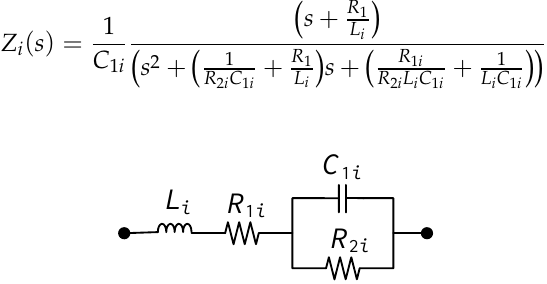
derived as Equation (9).